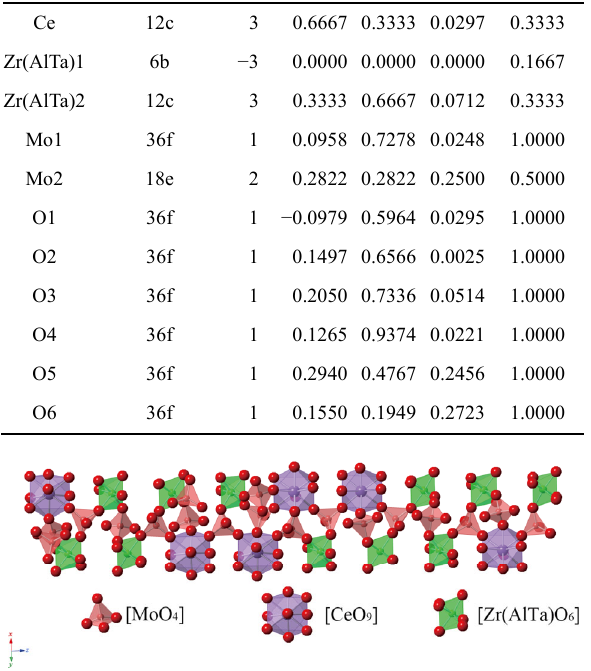
Fig. 4 Schematic illustration of CZMAT ceramics.